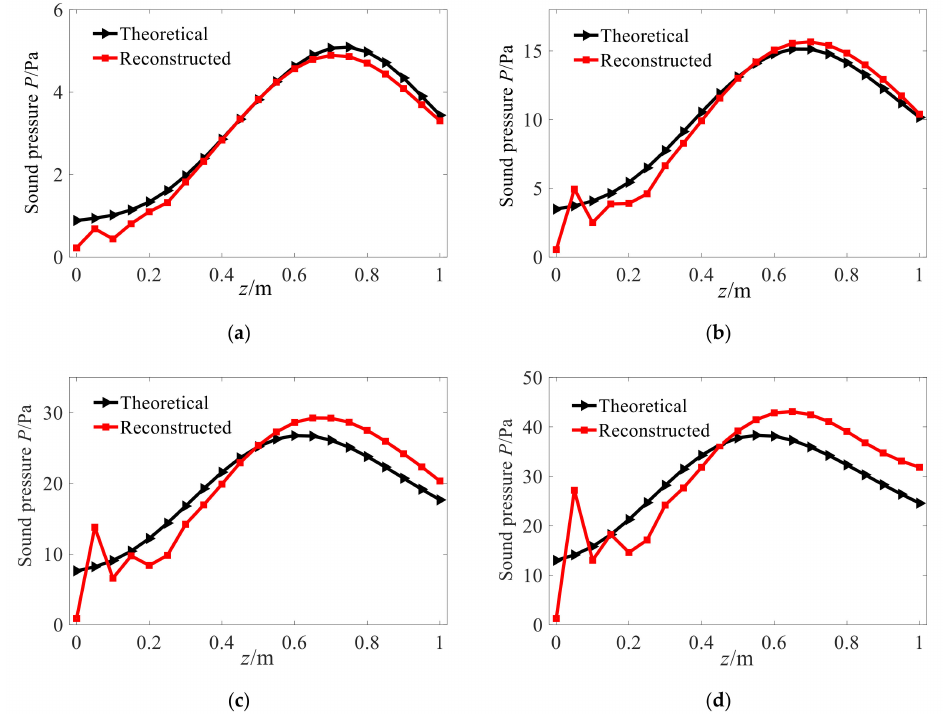
Figure 5. Pressure amplitude along θ = 0. ( a ) Conical angle with 15 ◦ . ( b ) Conical angle with 30 ◦ . ( c ) Conical angle with 45 ◦ . ( d ) Conical angle with 60 ◦